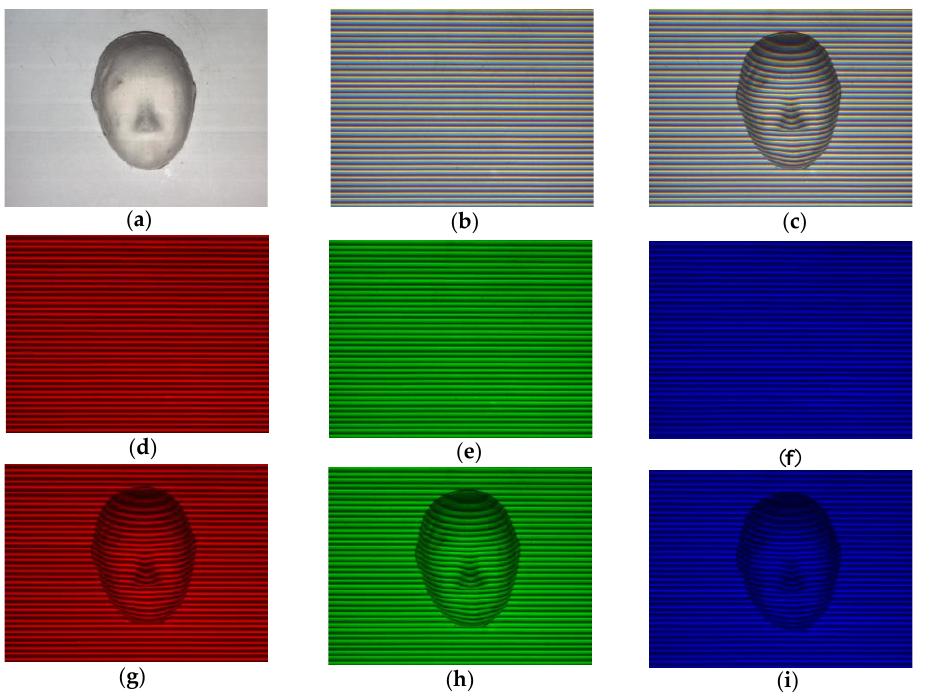
Figure 4. Experimental data: ( a ) measured object; ( b ) color fringe pattern; ( c ) color deformed pattern; ( d – f ) the demodulated monochromatic fringe patterns of R, G, and B; and ( g – i ) the demodulated monochromatic deformed patterns of R, G, and B.